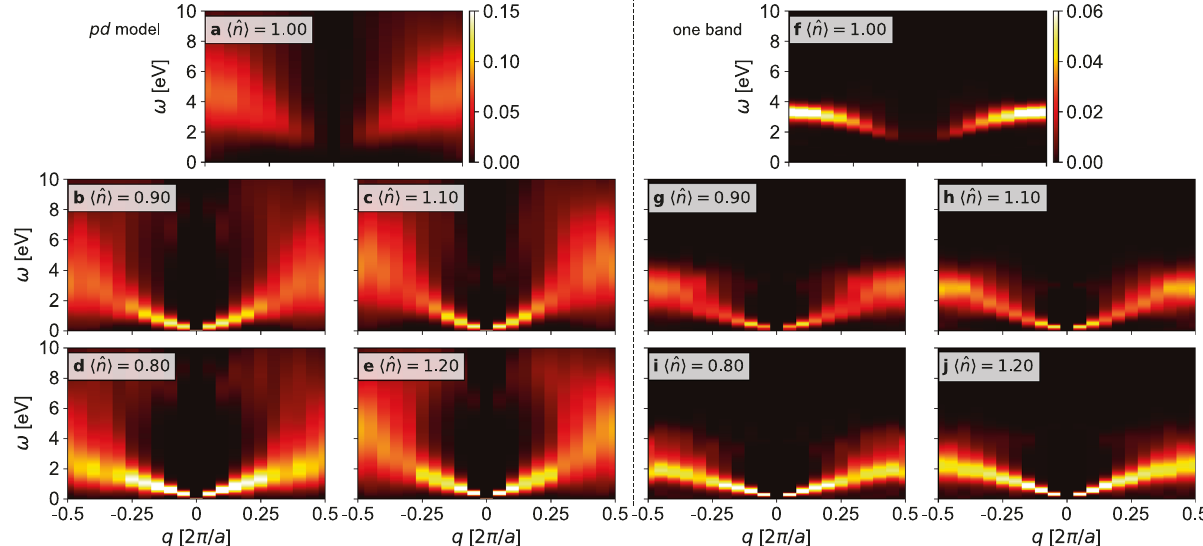
Fig. 7 Finite temperature determinant quantum Monte Carlo (DQMC) results for the total dynamical charge structure factor N ( q , ω ) of the multi- orbital pd - and single-band Hubbard models. Panels a − e show the dynamical charge structure N ( q , ω ) as a function of momentum q and energy ω , obtained from DQMC simulations of the multi-orbital with a Cu − O basis (the pd -model) at various fi llings h ^ n i , as indicated. Panels f − j show corresponding results for DQMC simulations of the single-band Hubbard model. Both sets of results were obtained using chains with N = 20 unit cells and at temperature T = 0.0625 eV. The model parameters are identical to those used in Fig. 4.